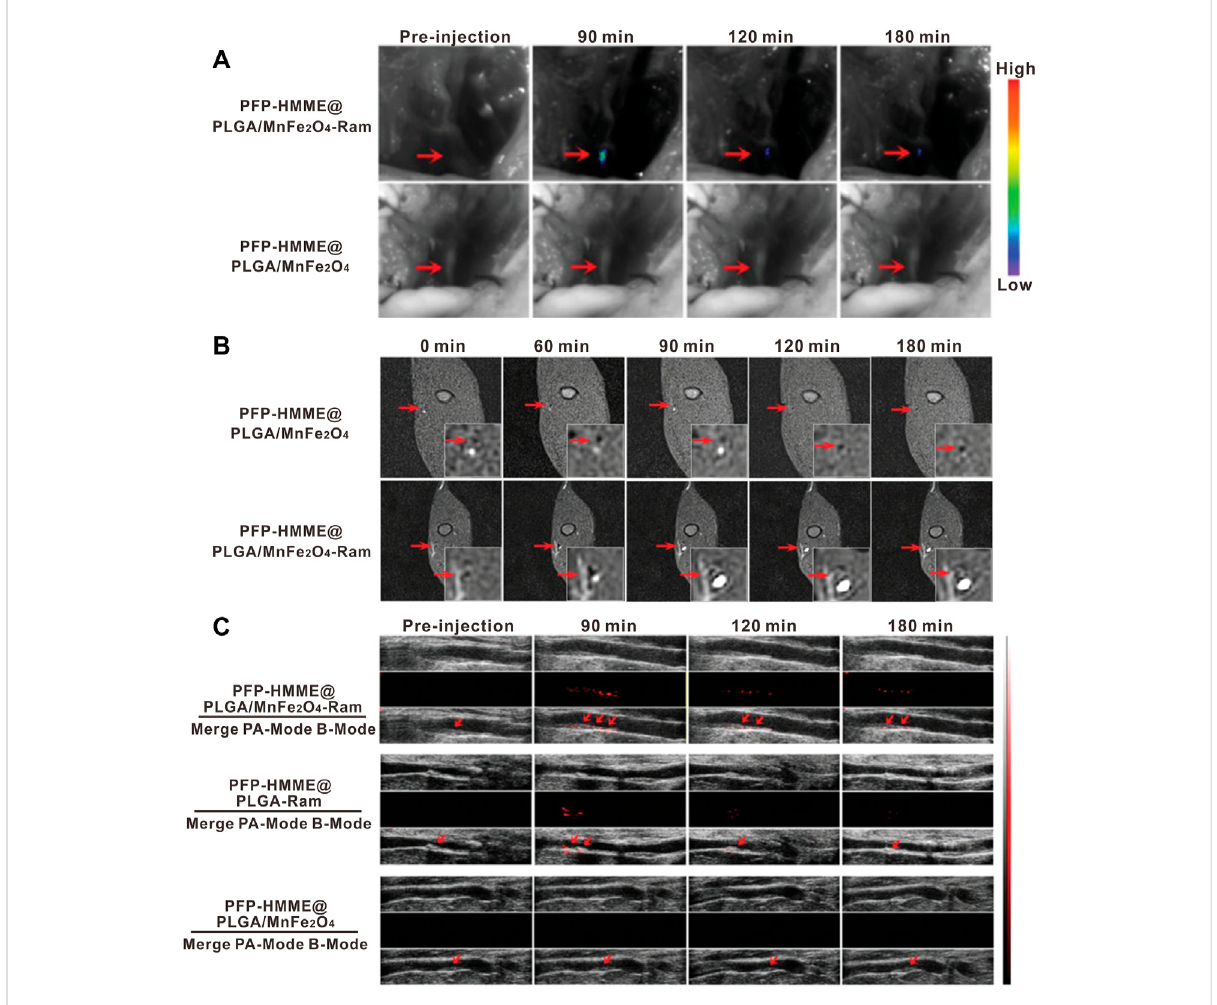
FIGURE 11 In vivo neovessel-targeting behavior of PFP-HMME@PLGA/MnFe MRI T 1 images, and (C) USoffemoralplaque-bearing rabbitsafter intravenousinjectionof targeted NPsand nontargeted NPsatdifferenttime points (Copyright permission from Wiley-VCH GmbH) (Yao et al.,